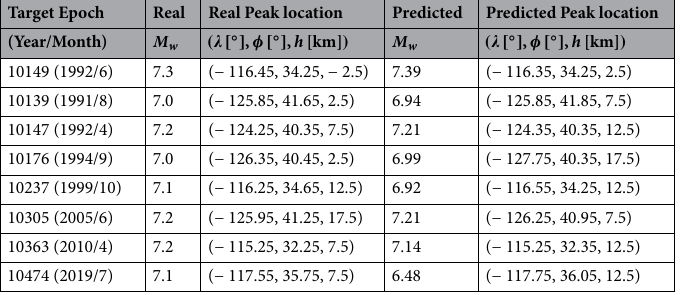
Table 2. Individual large earthquake reproductions using the best-so-far customized data-driven